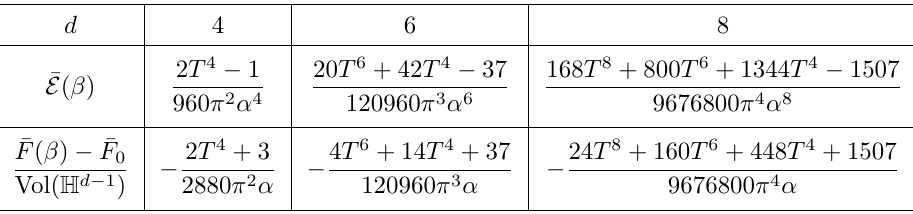
Table 4 . Thermal energy and free energy of a scalar (cid:12)eld conformally coupled to the hyperbolic background R (cid:2) H d (cid:0) 1 , written in terms of the dimensionless temperature T = 2 (cid:25)(cid:11)=(cid:12) for the (cid:12)rst few even space-time